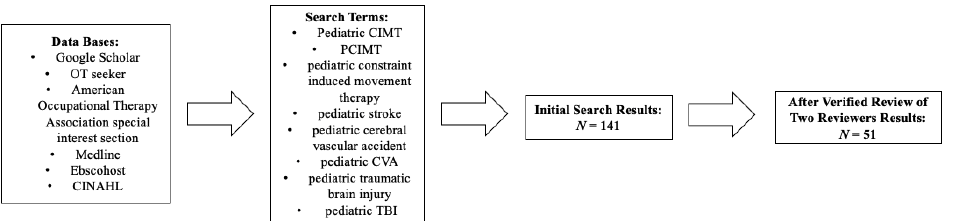
Figure 1. Search and Review Sequence.